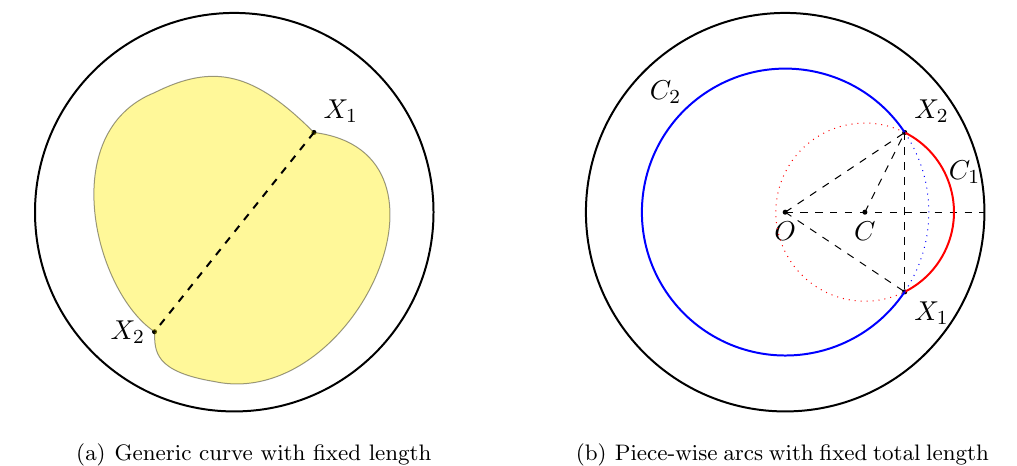
Figure 5 . (a) Geometric illustration of the minimization problem we need to solve. The total length of the curve is (cid:12)xed to be L . The \string" connects X 1 and X 2 tends to pull the two points closer, while the other term of the action prefers the curve to enclose a larger area. (b) For a (cid:12)xed distance D ( X 1 ; X 2 ) between X 1 and X 2 , the joint of two arcs maximizes the area enclosed by the curve. Then the entropy is determined by the minimum of action as a function of D ( X 1 ; X 2